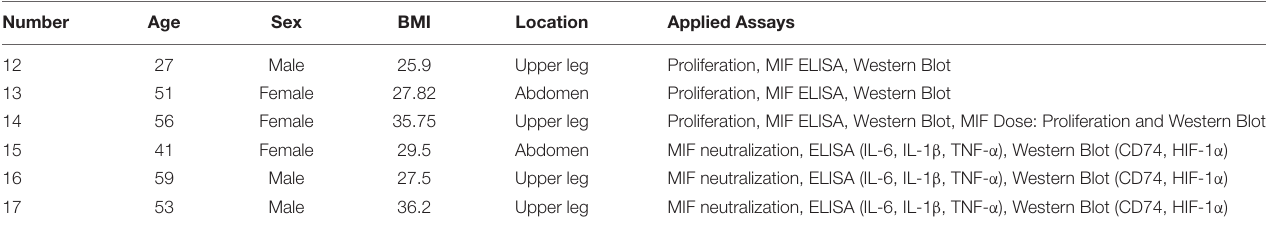
TABLE 2 | Details of adipose tissue samples from chronic non-healing wounds in group